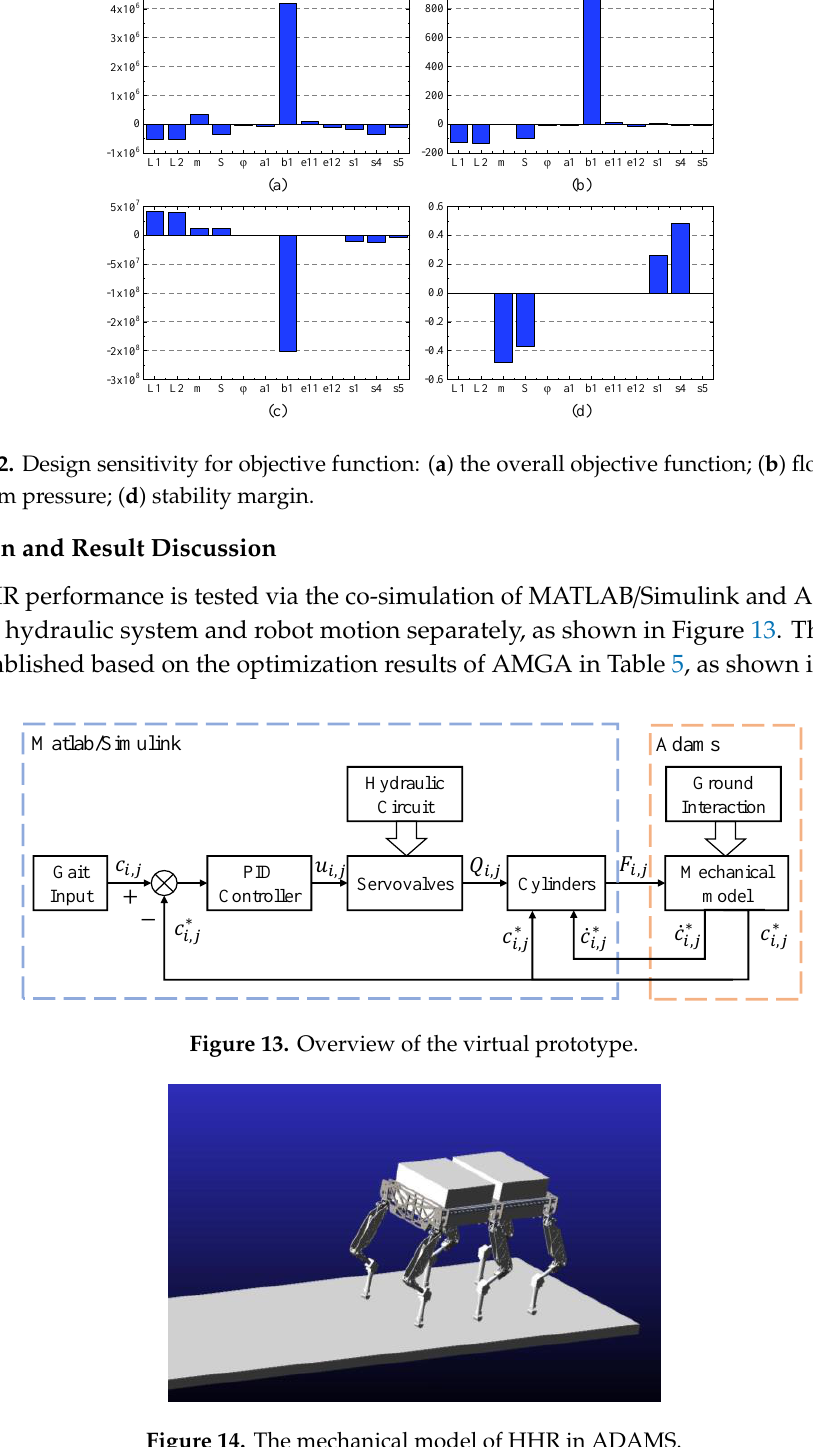
Figure 14. The mechanical model of HHR in ADAMS.